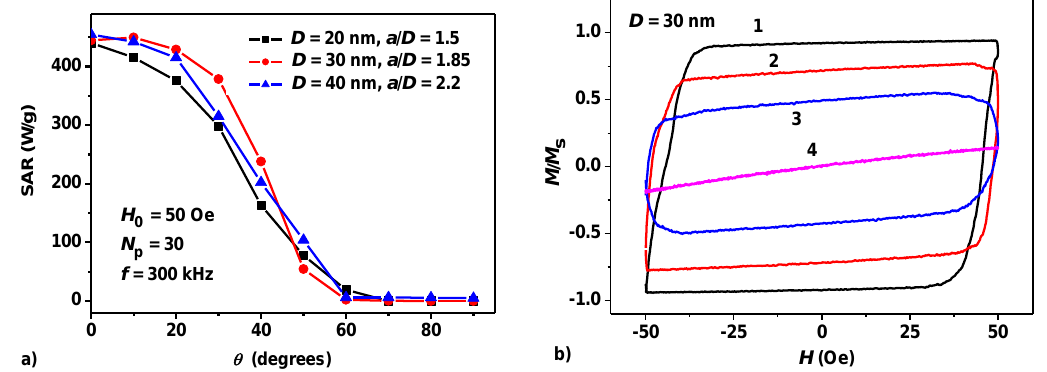
Figure 4. ( a ) Dependence of the assembly SAR on the angle of AC magnetic field with respect to the chain axis for assemblies of particles of different diameters. ( b ) The evolution of low frequency hysteresis loops for assembly of particles with diameter D = 30 nm for different directions of applied magnetic field with respect to the common chain axis: (1) θ = 0, (2) θ = 30 ◦ , (3) θ = 40 ◦ , (4) θ = 60 ◦ .